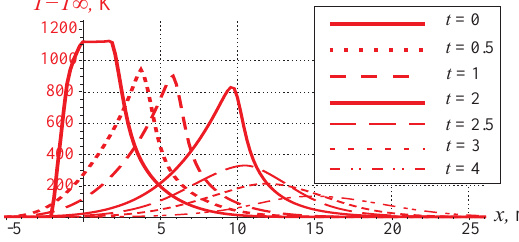
Figure 2. Dynamics of temperature decrease at moments t = 0 , 0 . 5 , 1 , 2 , 2 . 5 , 3 and 4 s. distributions of mass concentrations c 1 and c 2 of gas phase components and of temperature T are approaching to corresponding unperturbed values c 1 ∞ , c 2 ∞ and T ∞